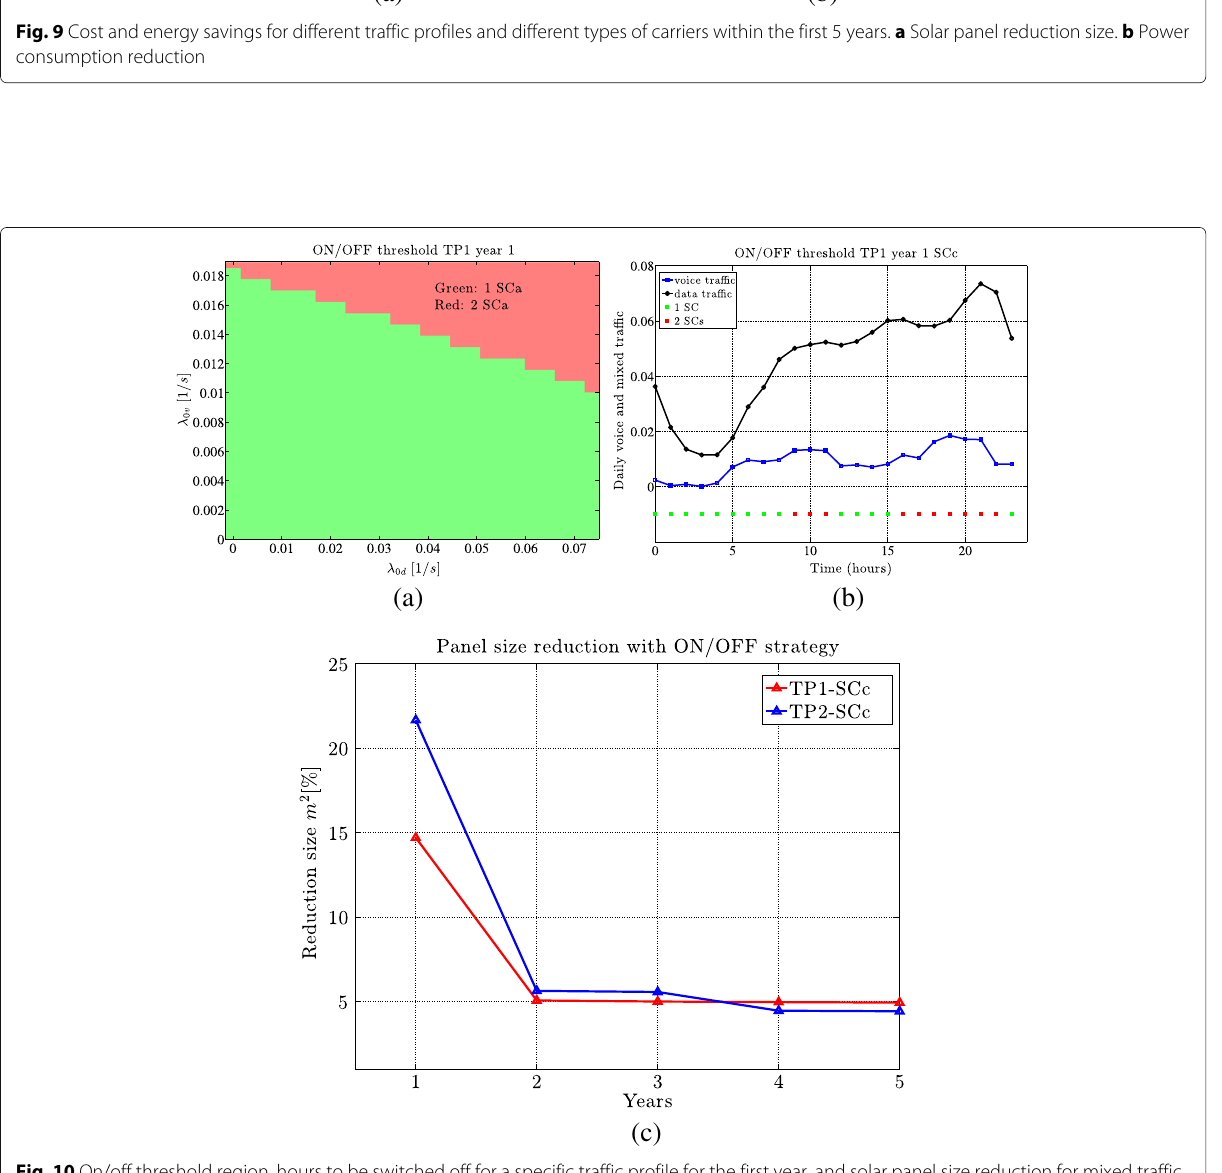
Fig. 10 On/off threshold region, hours to be switched off for a specific traffic profile for the first year, and solar panel size reduction for mixed traffic. a Region of lambda threshold for mixed traffic. b On/off threshold example for mixed traffic profile. c Solar panel size reduction for mixed traffic and two different traffic